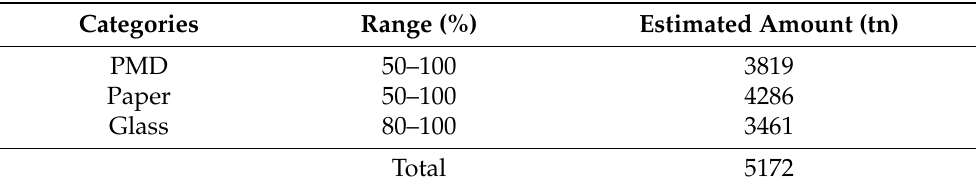
Table 3. Municipal Solid Waste Recycling Categories and